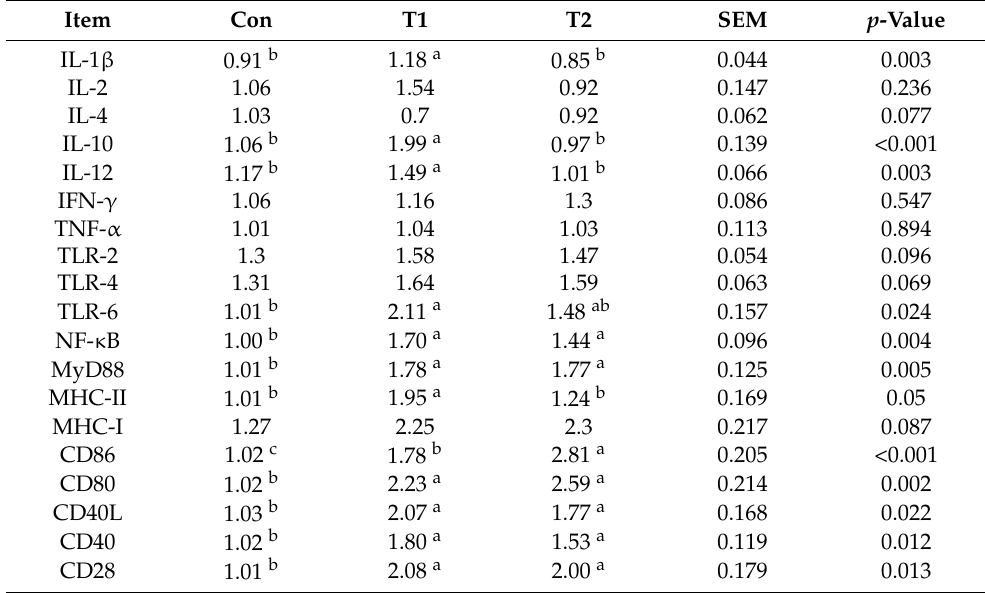
Table A3. The expression of immune-related genes in the cecal